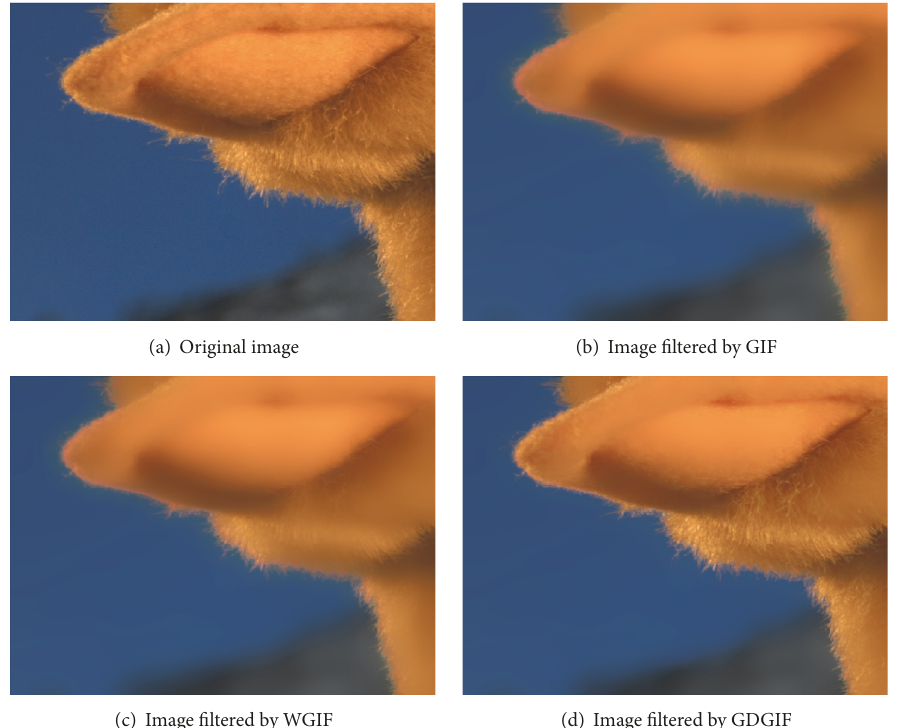
Figure 4: The difference between GIF, WGIF, and